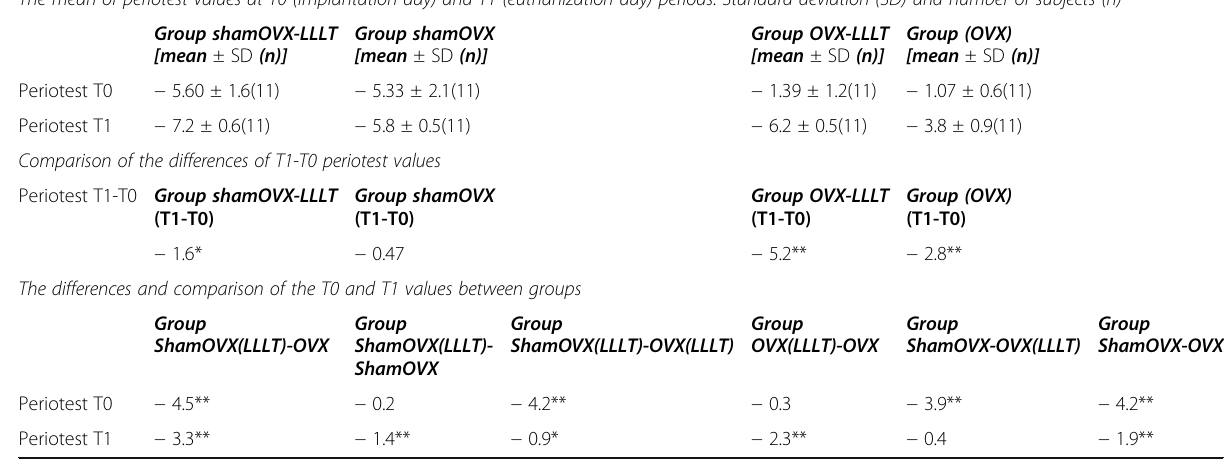
Table 2 The mean periotest values at T0 (implantation day) and T1 (euthanization day) periods, intra-group comparison of T1-T0 differences and comparison of T0 and T1 values between groups The mean of periotest values at T0 (implantation day) and T1 (euthanization day) periods. Standard deviation (SD) and number of subjects (n) Group shamOVX-LLLT Group shamOVX [mean ± SD (n)] [mean ± SD (n)]